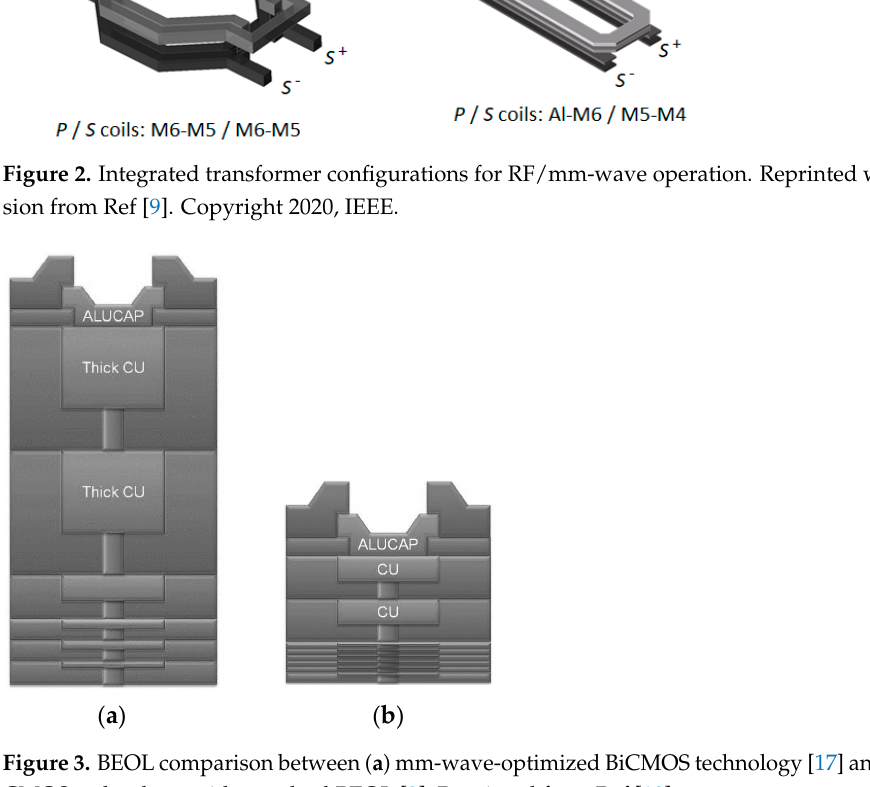
Figure 2. Integrated transformer configurations for RF/mm-wave operation. Reprinted with permission from ref. [9] . Copyright 2020, IEEE.